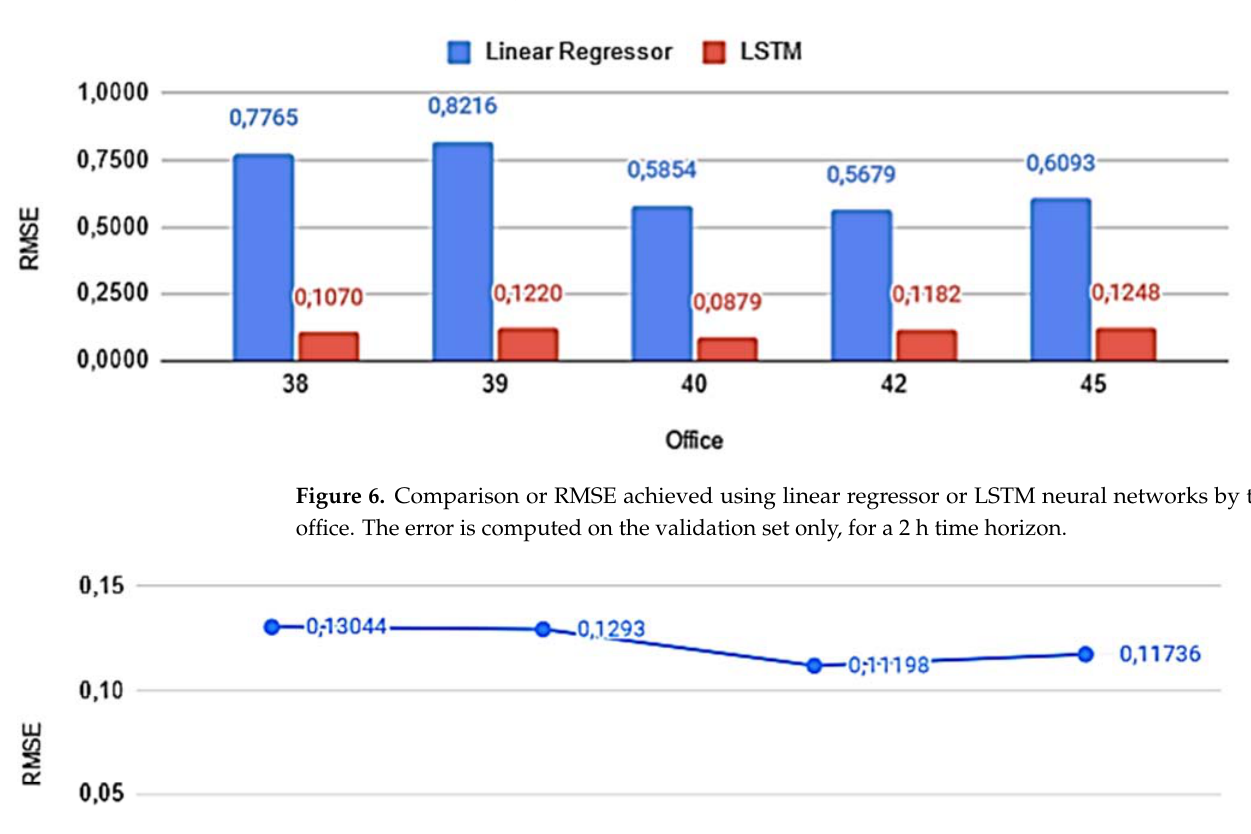
Figure 6. Comparison or RMSE achieved using linear regressor or LSTM neural networks by the office. The error is computed on the validation set only, for a 2 h time horizon.